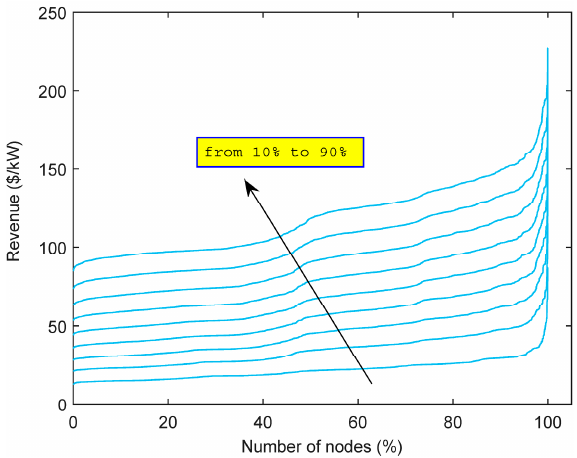
Figure 19. Sensitivity analysis for the revenue in dollars per kW, considering round trip efficiency from 10% to 90%, increasing in increments of 10%. LMP data for 2014 in RTM, 10 h discharge duration.